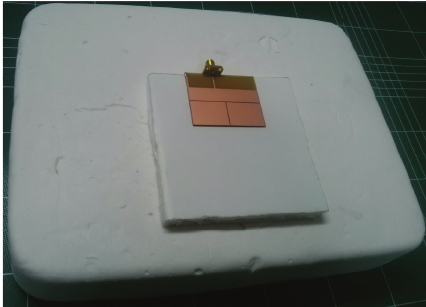
Figure 11: Measurement set-up of the prototype antenna on the manufactured phantom.